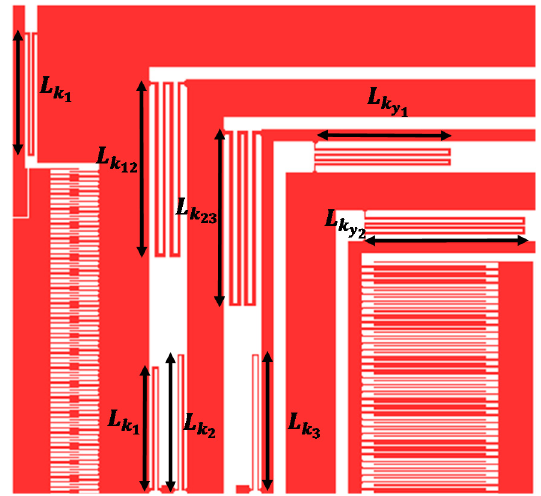
Figure 5. Mechanical suspension design for the proposed MEMS gyroscope design.